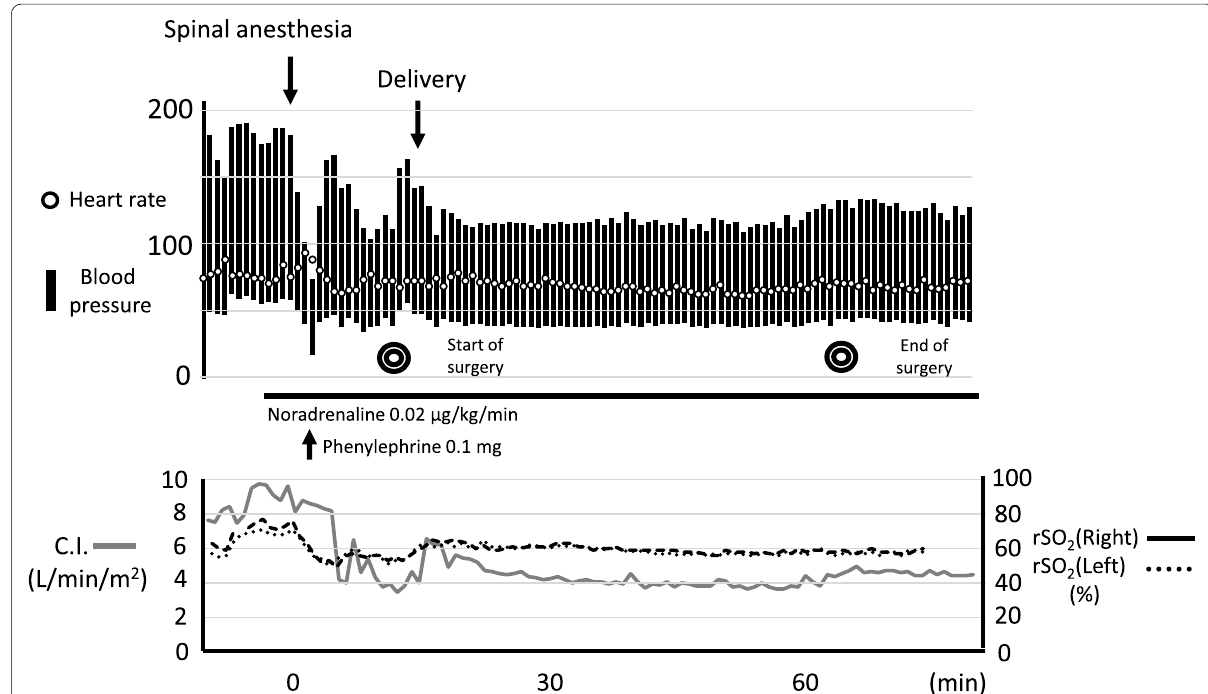
Fig. 2 Intraoperative changes in circulatory dynamics and regional cerebral tissue oxygen saturation. rSO 2 , regional cerebral tissue oxygen saturation; C.I., cardiac